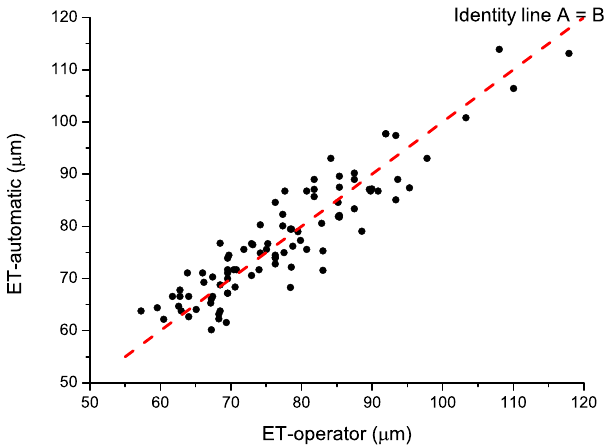
Fig. 4. Correlation between automated and manual measurement.